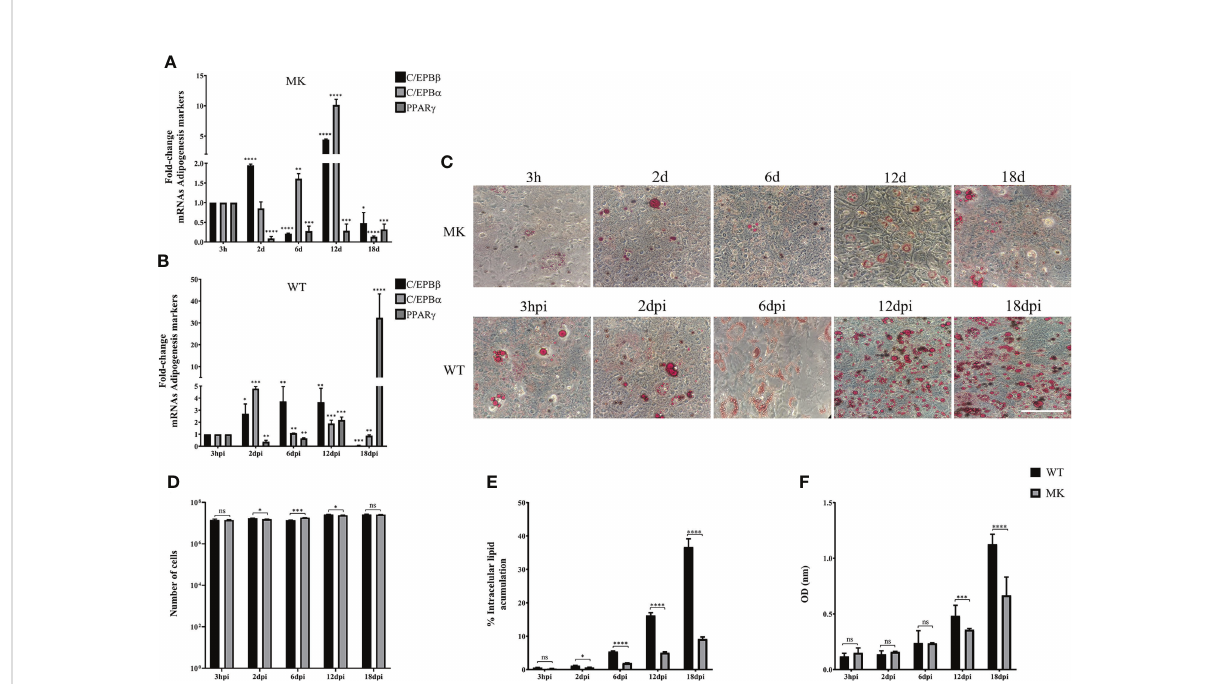
FIGURE 4 HAdV-D36 infection increases adipogenesis in 3T3-L1 cells. 3T3-L1 cells at 12 dpc were infected with HAdV-D36 without adipocyte differentiation inducers (MM) and the expression levels of C/EBP b , C/EBP a and PPAR g were analyzed by RT-qPCR (A, B) . Intracellular lipid accumulation was observed by ORO staining and white fi eld microscopy (C) . Scale bar = 100 m m. Cell numbers were measured using a Neubauer chamber (D) . Change in the percentage of cells with lipid accumulation in the absence of MDI were counted using ORO staining and white fi eld microscopy (E) , the relative quantities of lipid accumulation were determined by elution of ORO staining, measured at 510 nm Optical Density (OD) (F) . Primers were designed to hybridize at exon-exon junctions to measure mature mRNA. All values represent the mean of two independent experiments, measured in technical duplicates. Data are expressed as the mean and error bars represent standard deviations. Signi fi cant differences from each time-point relative to 3h (A, B) and between Mock- and HAdV-D36-infected cells at each time-point (D-F) are indicated by *p < 0,05. **p < 0,005. ***p < 0,0005. ****p < 0,00001. ns, not signi fi